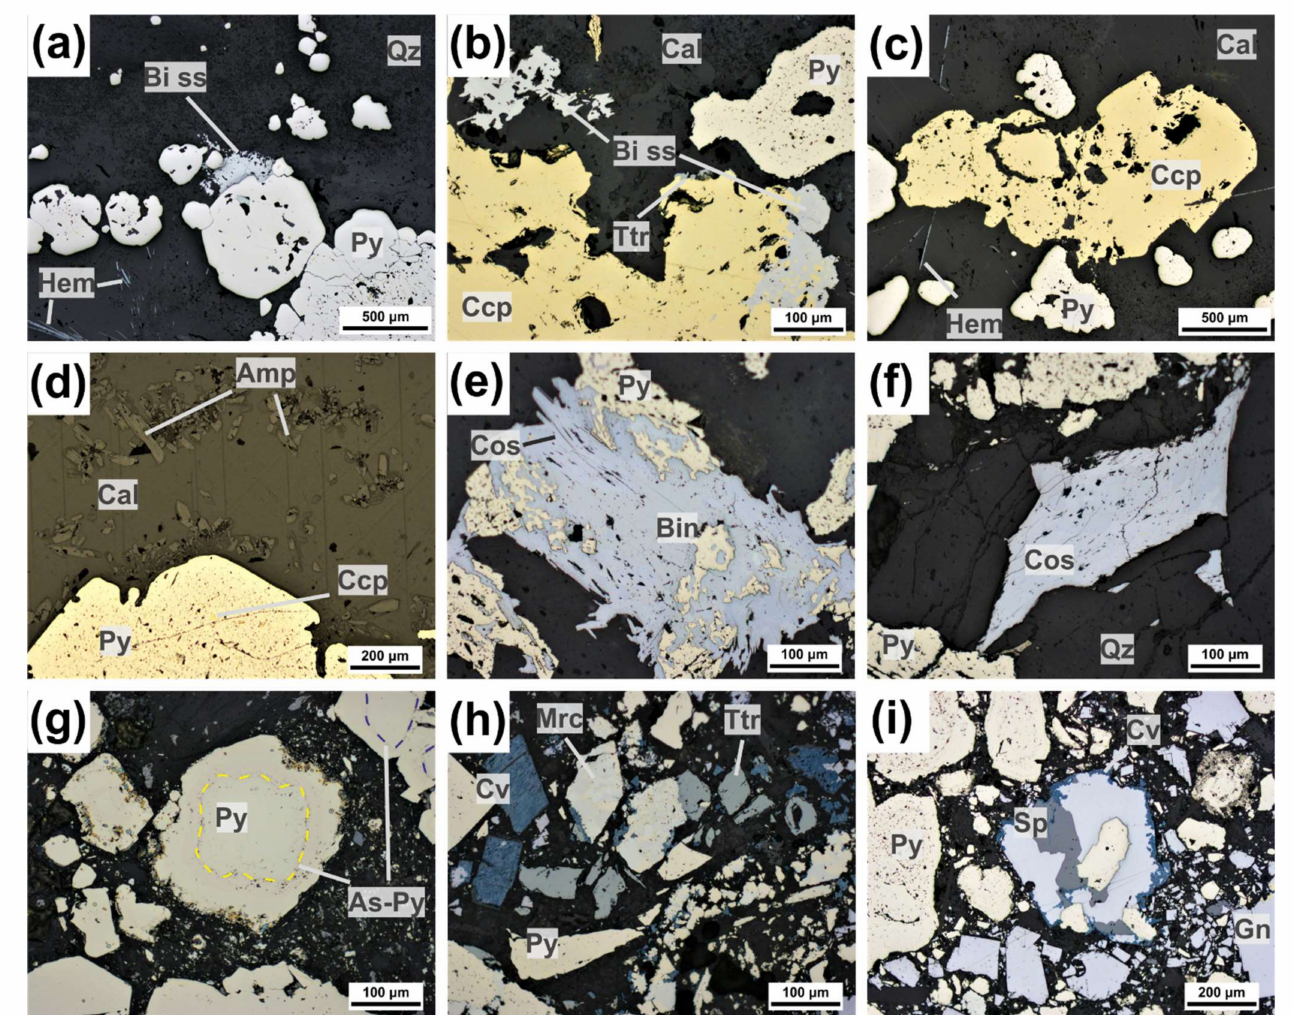
Figure 4. Reflected-light photomicrographs of polymetallic mineralization from the Kizhnica quarry: ( a ) aggregates of Bi sulfosalts overgrowing pyrite; hematite crystals in quartz; ( b ) aggregates of Bi sulfosalts and tetrahedrite group minerals overgrowing chalcopyrite in calcite veinlet; ( c ) subhedral chalcopyrite crystal, pyrite, and hematite crystals in calcite veinlets; ( d ) pyrite crystal with chalcopyrite inclusions in calcite veinlet with euhedral amphibole crystals; ( e ) aggregate of cosalite with bismuthinite replacing pyrite; ( f ) cosalite crystals in quartz–pyrite matrix; ( g ) irregular pyrite with arsenian pyrite zones from pyrite-galena-quartz breccia; ( h ) pyrite, tetrahedrite group minerals, marcasite, and covellite clasts from pyrite-galena-quartz breccia; ( i ) Pyrite crystals and galena–sphalerite aggregates with secondary covellite from pyrite-galena- quartz breccia. Abbreviations: Amp = amphiboles; As-Py = arsenian pyrite; Bi ss = bismuth sulfosalts; Bin = bismuthinite; Cal = calcite; Ccp = chalcopyrite; Cos = cosalite; Cov = covellite; Gn = galena; Hem = hematite; Mrc = marcasite; Qz = quartz; Py = pyrite; Sp = sphalerite; Ttr = tetrahedrite group